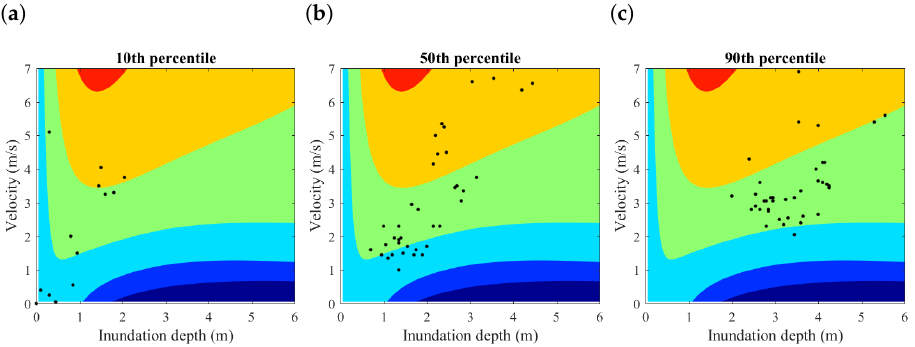
Figure 9. Distribution of inundation depth and flow velocity for RC structures of region R2 in Sendai: ( a ) 10th percentile; ( b ) 50th percentile; and ( c ) 90th